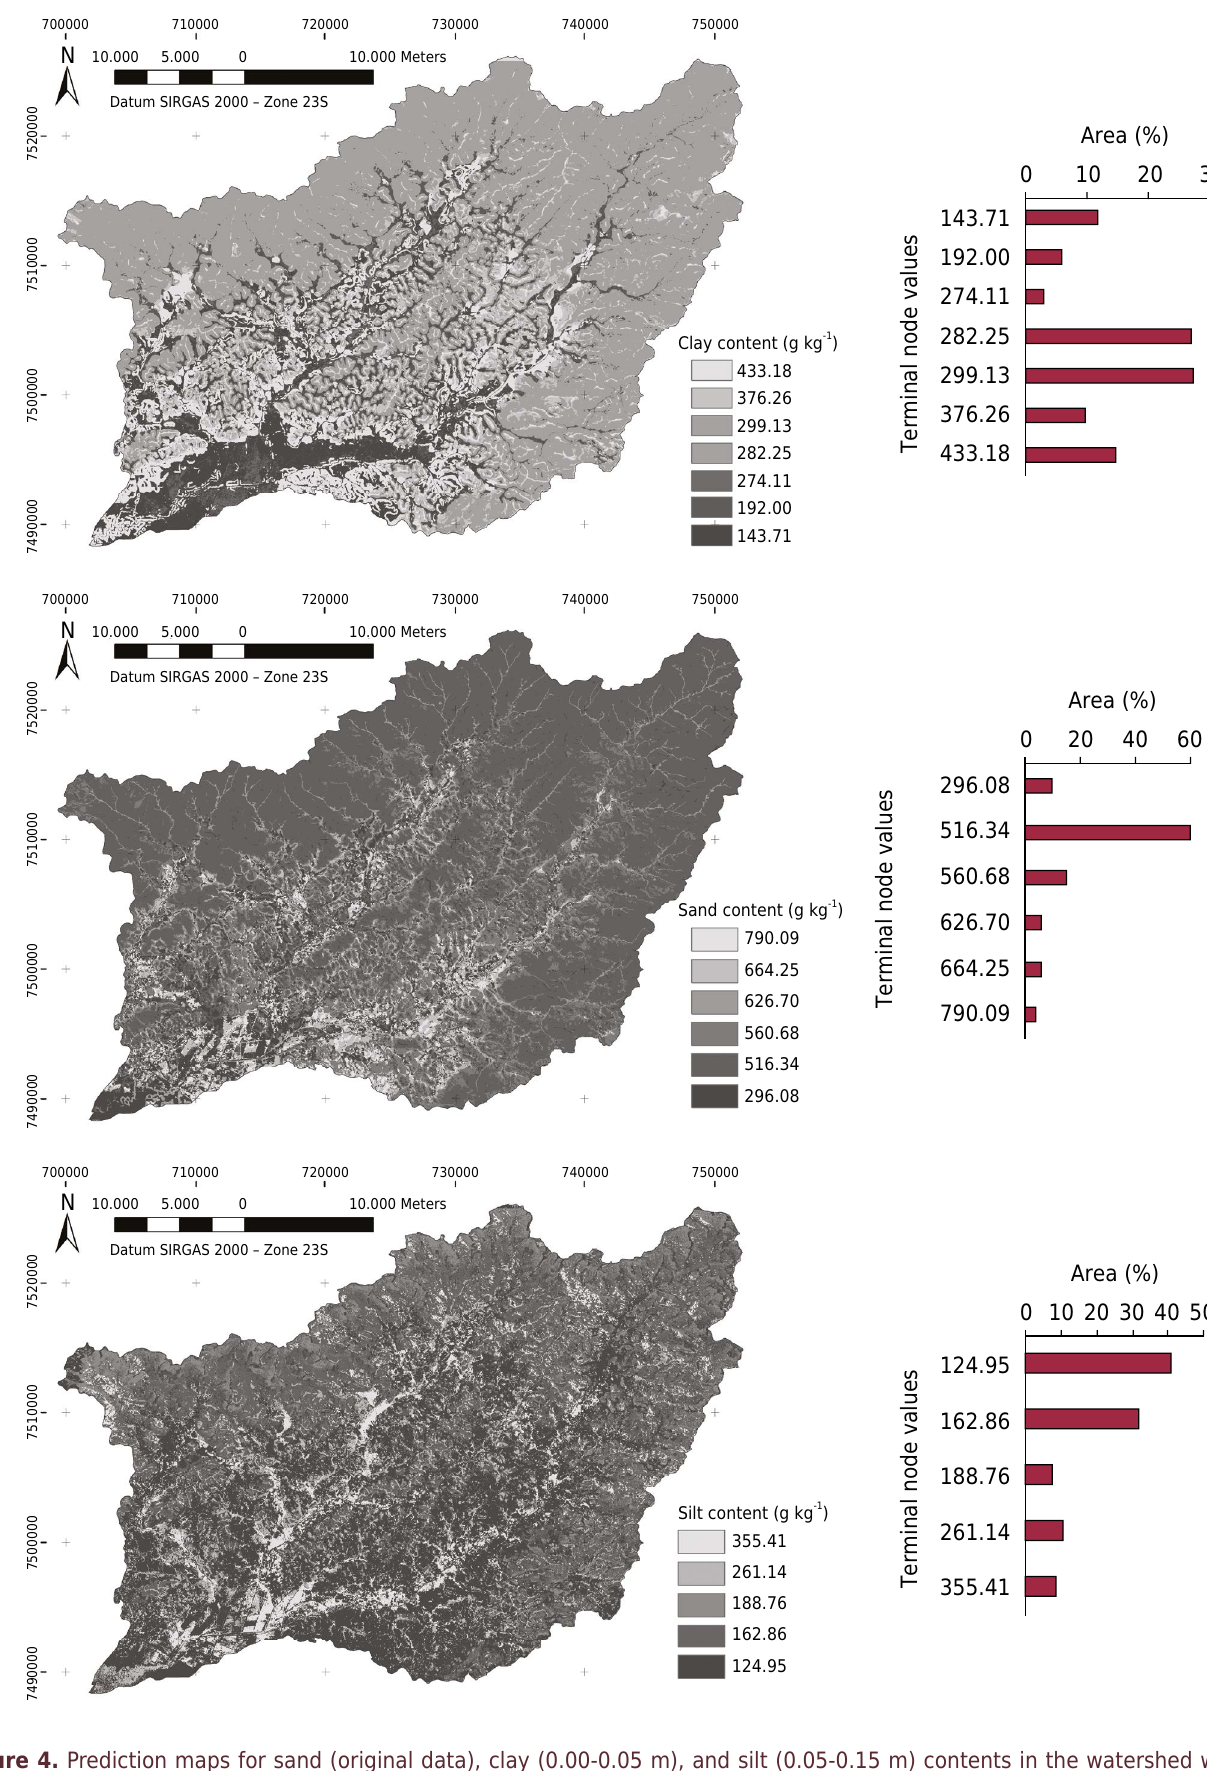
Figure 4. Prediction maps for sand (original data), clay (0.00-0.05 m), and silt (0.05-0.15 m) contents in the watershed with the graphs illustrating the area related to the terminal